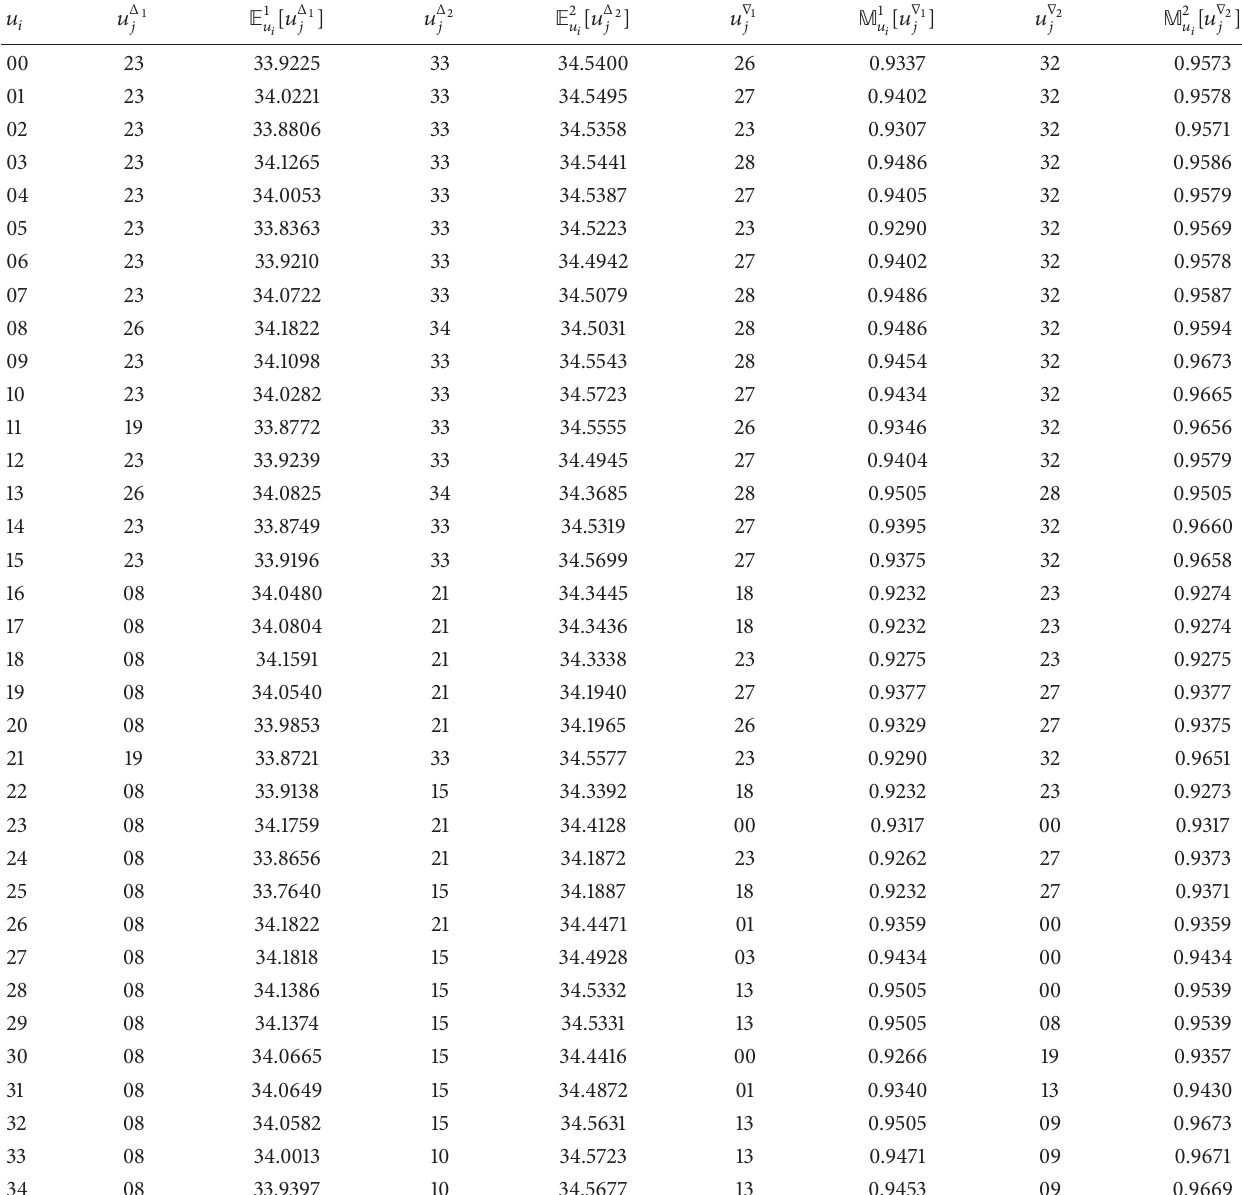
Table 1: All the major data produced by SUM - MAX and MIN - MAX